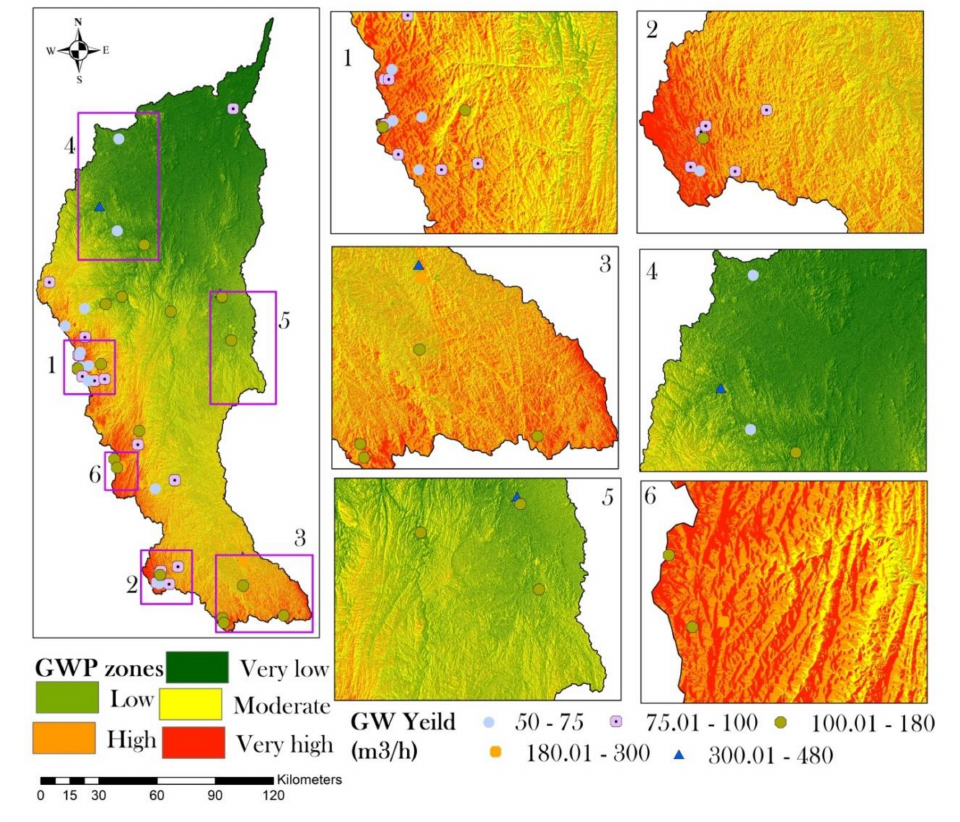
Figure 7. Groundwater potentiality model using LR-based novel hybrid